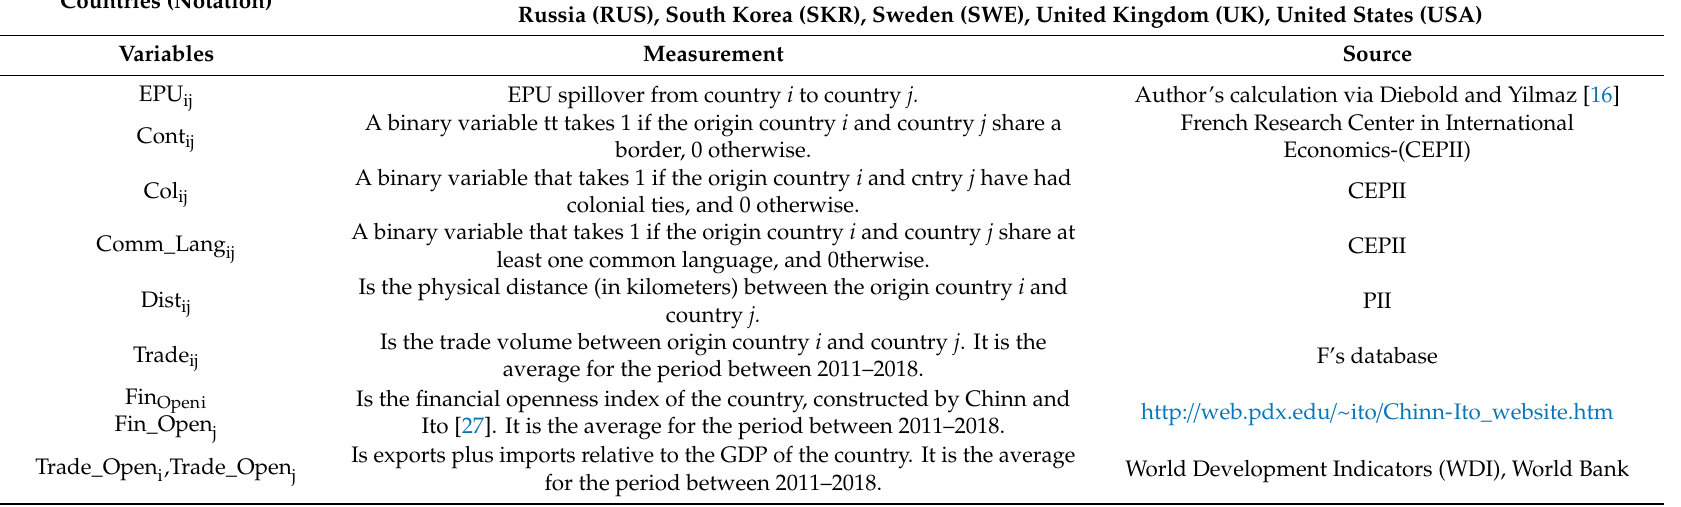
Table A1. List of the countries and